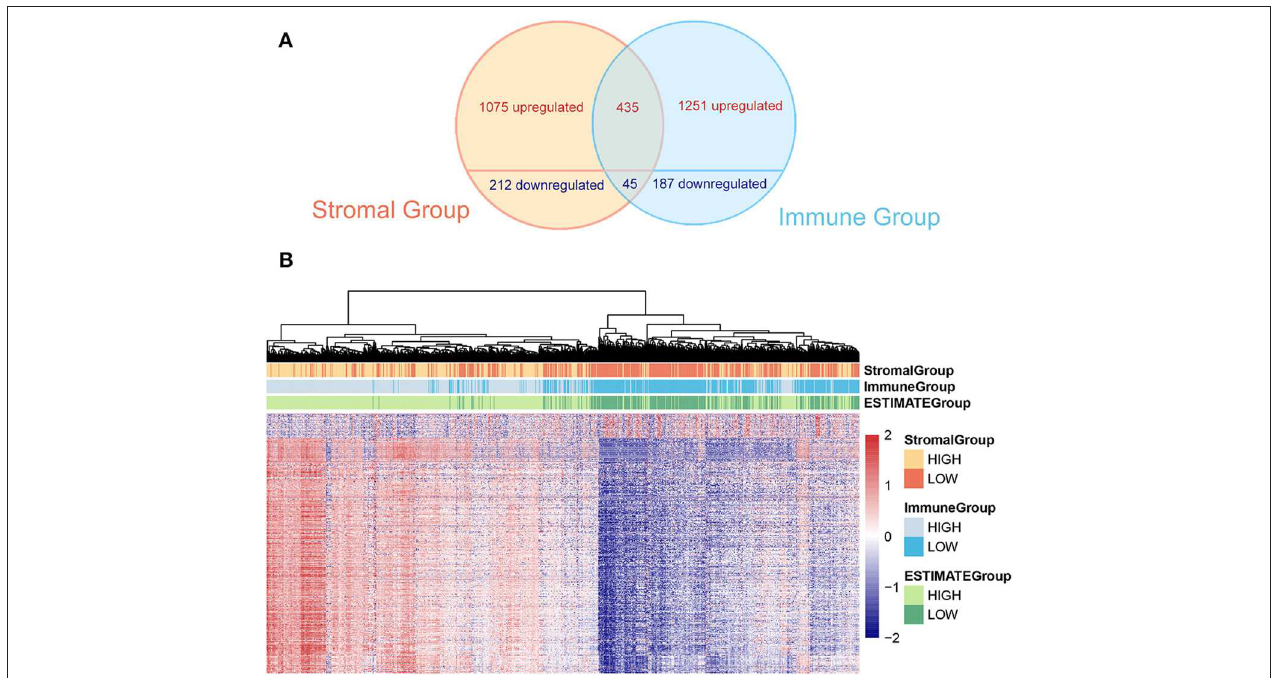
FIGURE 2 | (A) The Venn graph shows intersection of DEGs in stromal and immune group. Four hundred and thirty-five upregulated and 45 downregulated genes are found. (B) The heatmap demonstrates DEGs and the stromal score, the immune score, and the tumor purity (ESTIMATE score) at the top of the heatmap.